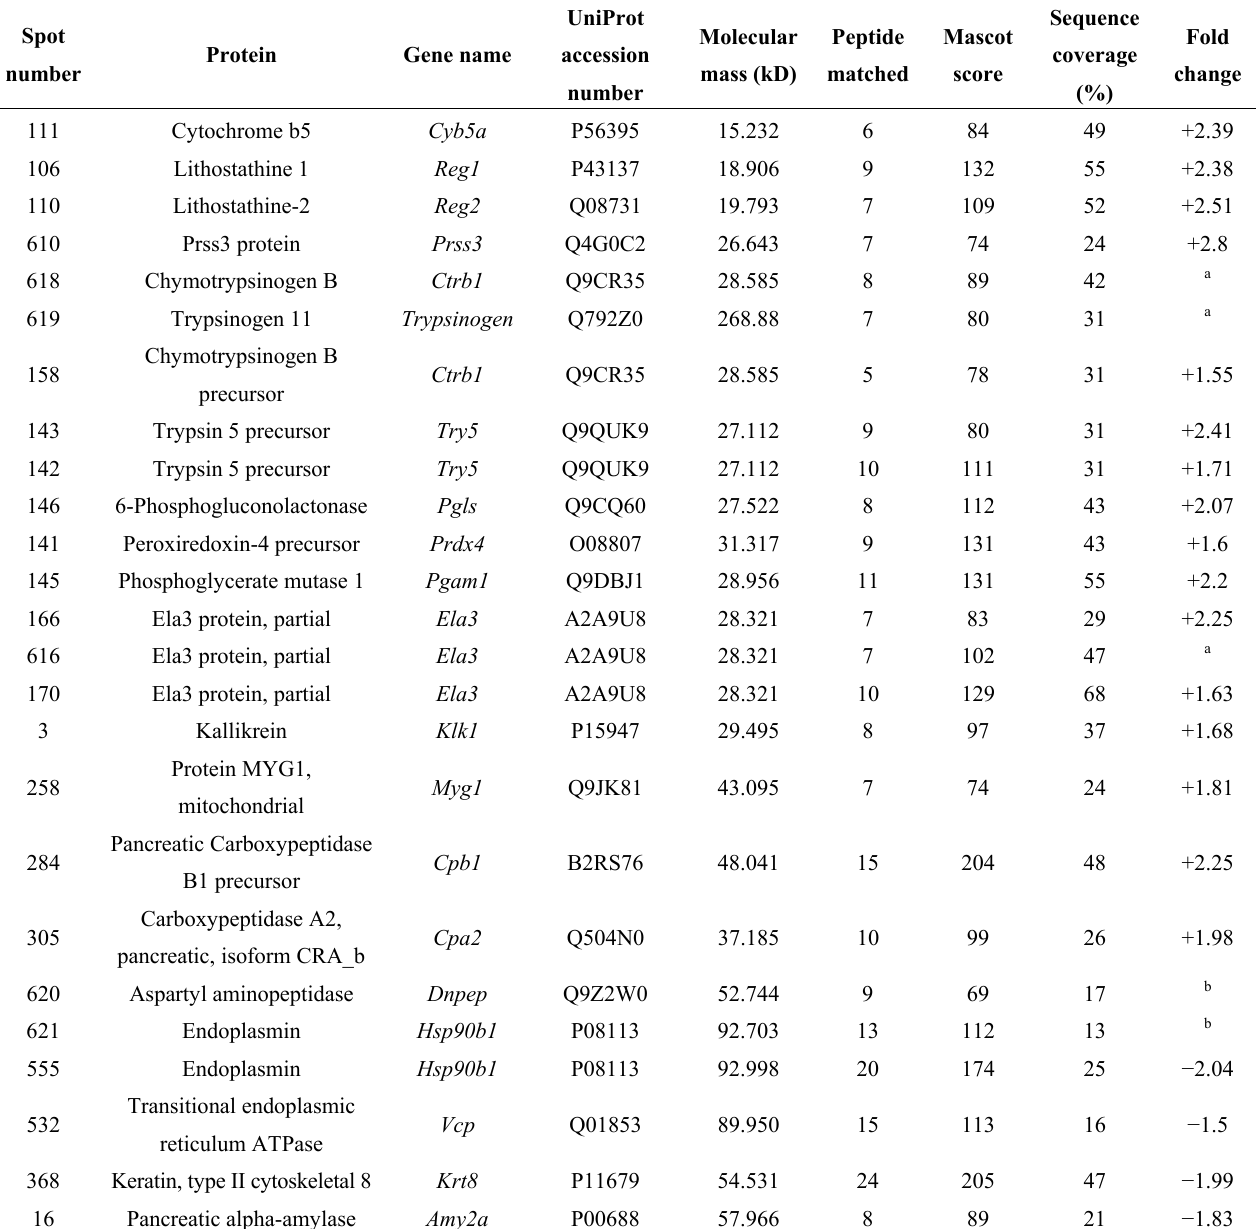
Table 1. Proteins identified differentially expressed in the mouse pancreas db / db